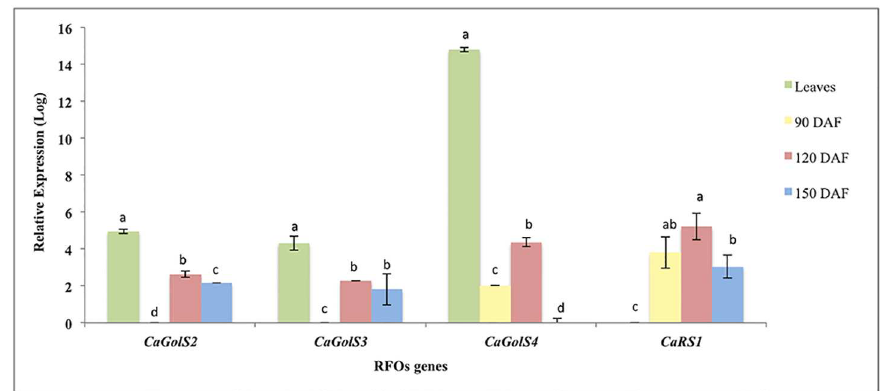
Fig 4. qRT-PCR analysis of selected RFO-related genes. Leaves are represented in green and perisperm in yellow (90 DAF), red (120 DAF) and blue (120 DAF). Relativeexpressionvalues are represented in Log10 scale. Calibrator tissue is always the minimalgene expressionvalue. Lower-caseletters, from a to d , representstatistically significantdifferences for each RFO gene amongcoffee tissues (leavesand perisperm from 90 to 150